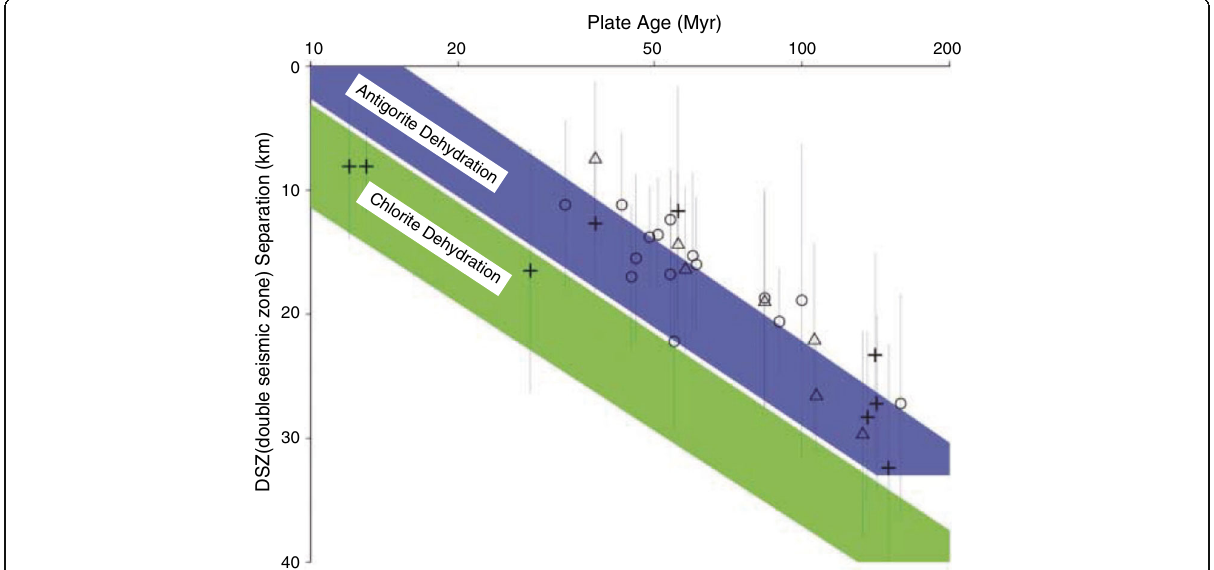
Fig. 6 Separation of the double seismic zone plotted against the age of the subducting slab. Distances between the upper and lower seismic planes are shown by three different symbols: triangles show typical down-dip compression overlying down-dip extension, circles indicate a different pattern, and crosses denote unknown. Vertical lines attached to the symbols are one-standard deviation uncertainties from Gaussian fits. Predicted separations of the double seismic zones based on the lower seismic planes resulting from the dehydration of antigorite and chlorite based on Hacker et al. (2003) are shown as blue and green shaded areas , respectively. (After Brudzinski et al.